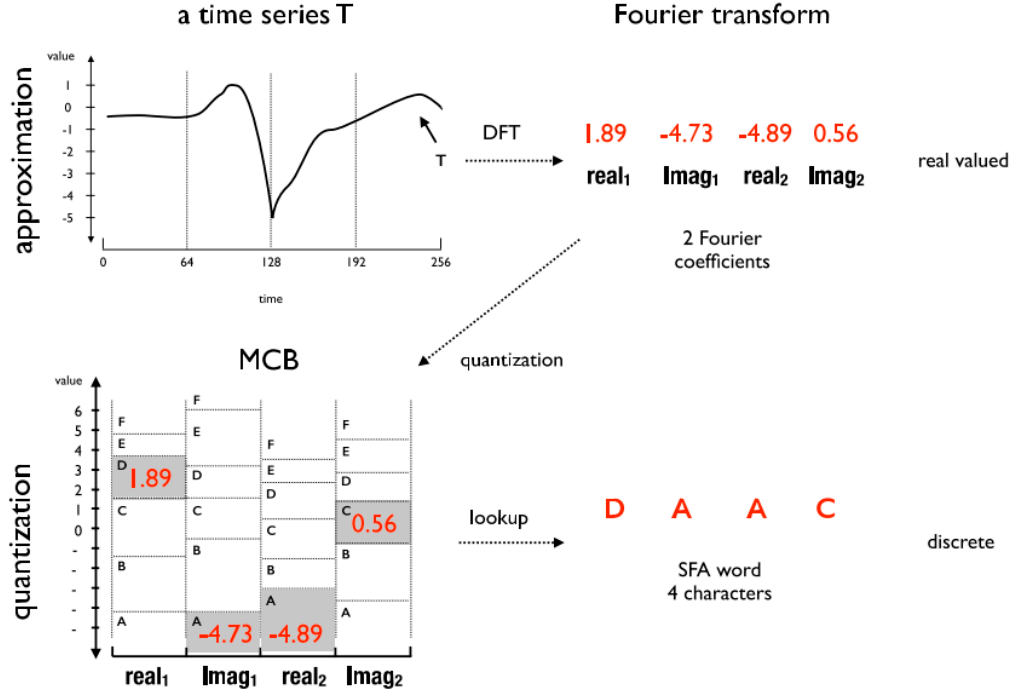
Figure 6. Subsequence T is approximated using the DFT and quantized using the MCB to finally generate the word ‘DAAC’ of size 4 and alphabet of size 6 [29].